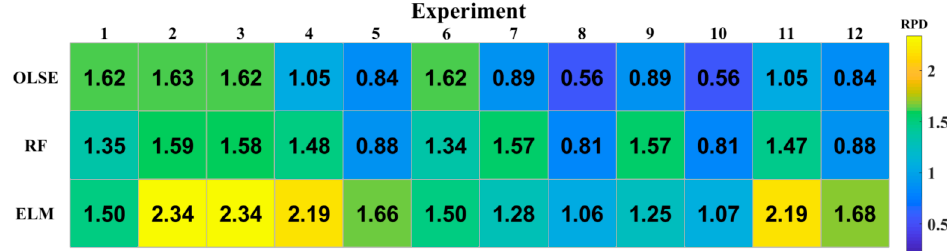
Figure 5. Usability of different predicted models with different preprocessing approaches.